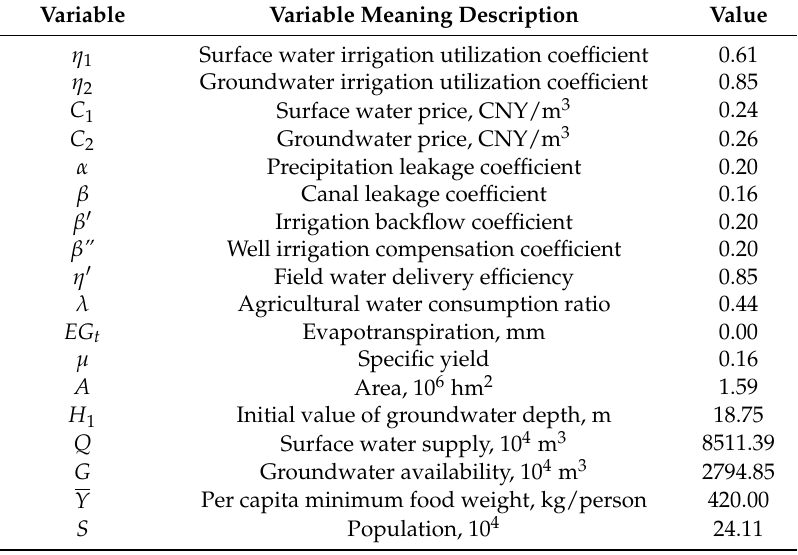
Table 5. Variable